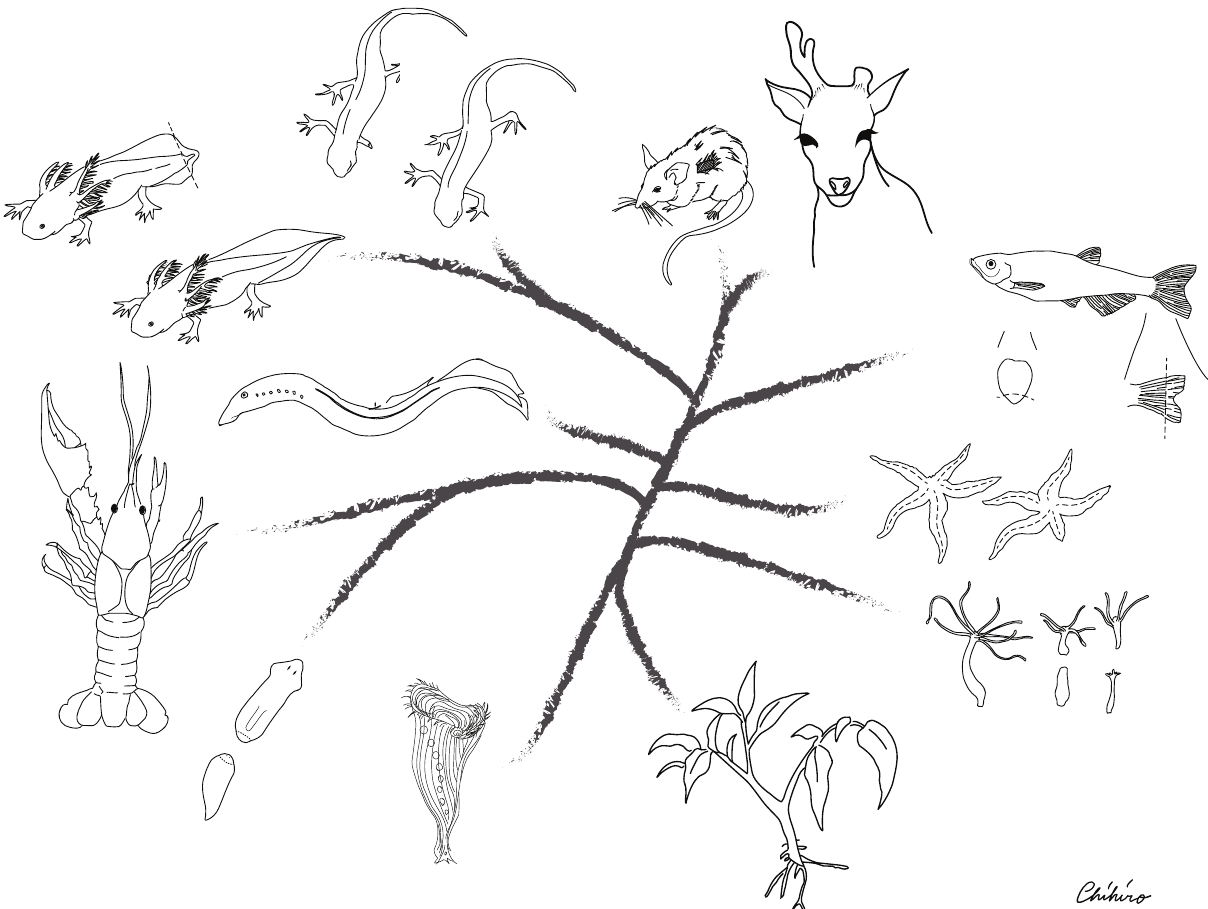
Figure 1: Phylogenetic distribution of regenerative organisms. Regenerative abilities tend to decline as complexity increases through evolution. For instance, Hydra and planarians can regenerate their whole bodies, whereas regeneration in deer or African spiny mice is limited to certain parts of their body such as antlers or skin, respectably. The following representatives from different phyla are illustrated: plants, Stentor (Ciliophora), Hydra (Cnidaria), planarian (Platyhelminthes), crayfish (Crustacea), starfish (Echinodermata), lamprey, fish, axolotl, and newt (Urodela), as well as deer and spiny mouse (Mammalia). Phylogenetic distances and organisms are not drawn to scale. Illustration contributed by Chihiro Uchiyama